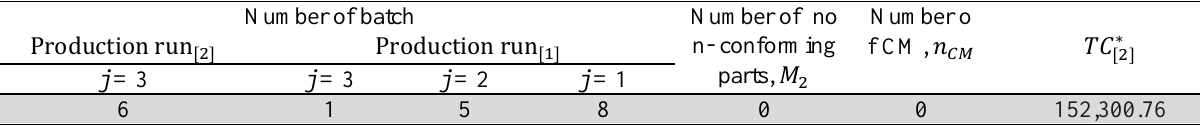
The decision variable of the best solution for constant